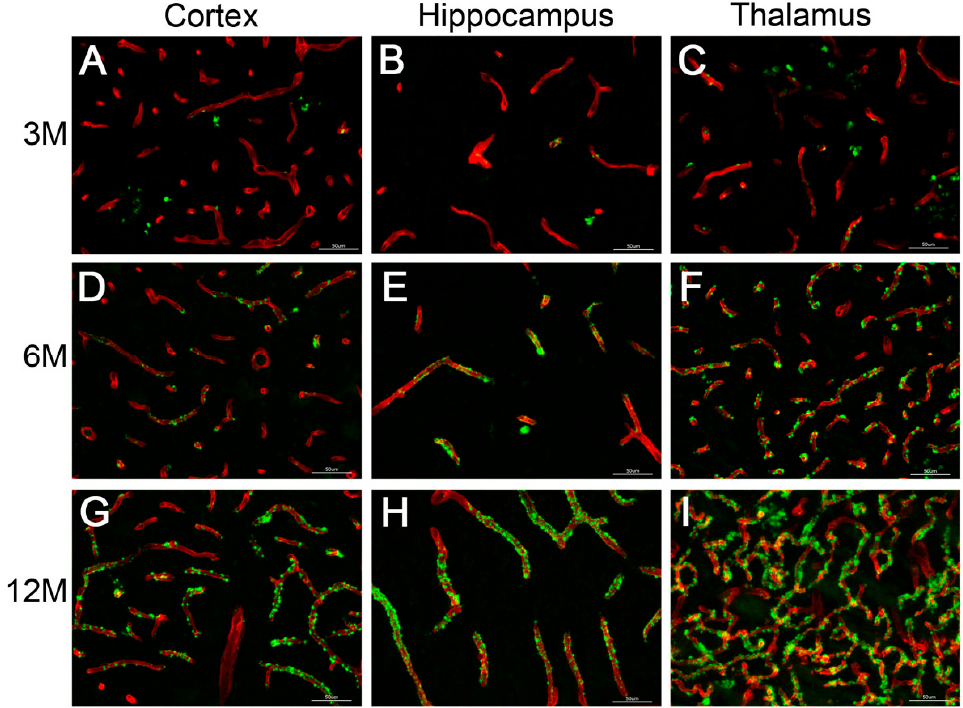
Figure 2. Cerebral microvascular amyloid accumulation in rTg-DI rats. Representative brain sections from 3-, 6- and 12-month-old rTg-DI rats not tested in behavior that were stained with thioflavin S to identify fibrillar microvascular amyloid (green) and immunolabeled with an antibody to collagen IV to identify cerebral blood vessels (red). Progressive accumulation of microvascular amyloid deposits is observed in the cortex ( A , D , G ) hippocampus ( B , E , H ) and thalamus ( C , F , I ). Scale bars = 50 µm.